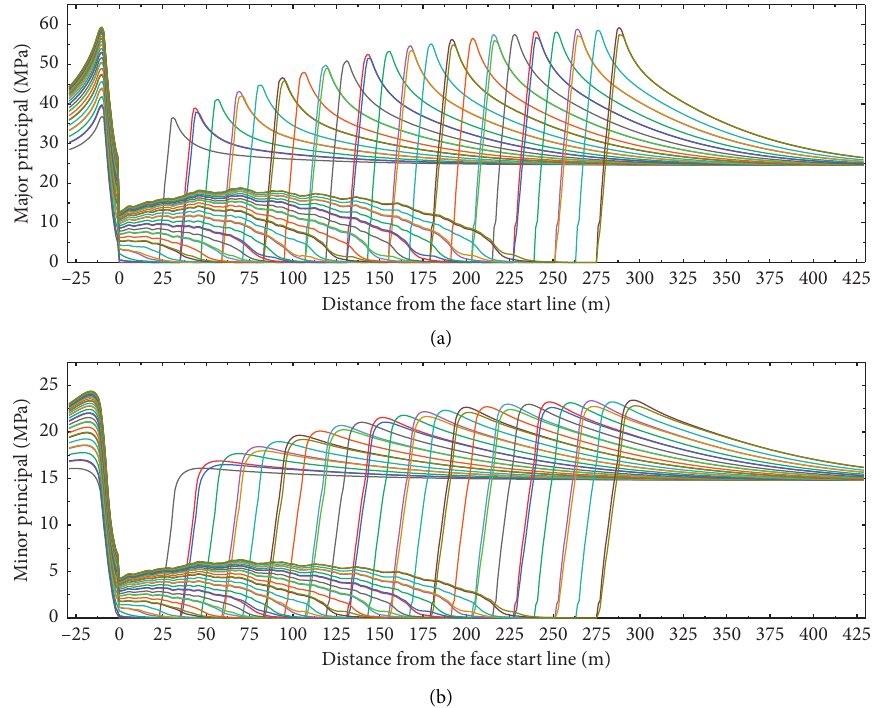
Figure 9: The evolution of the principal stress with face advancement. (a) Major principal stress. (b) Minor principal stress.